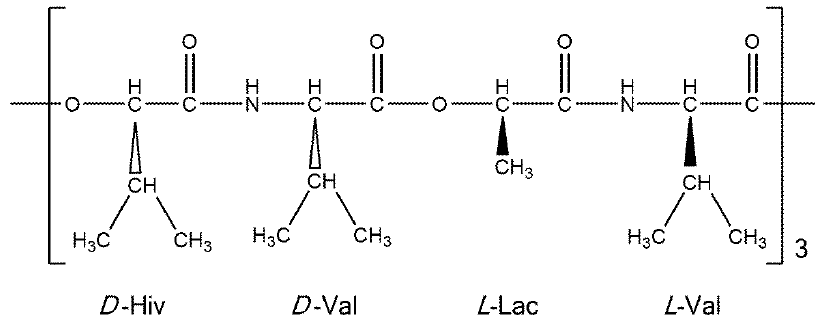
Figure 1. A schematic representation of valinomycin.